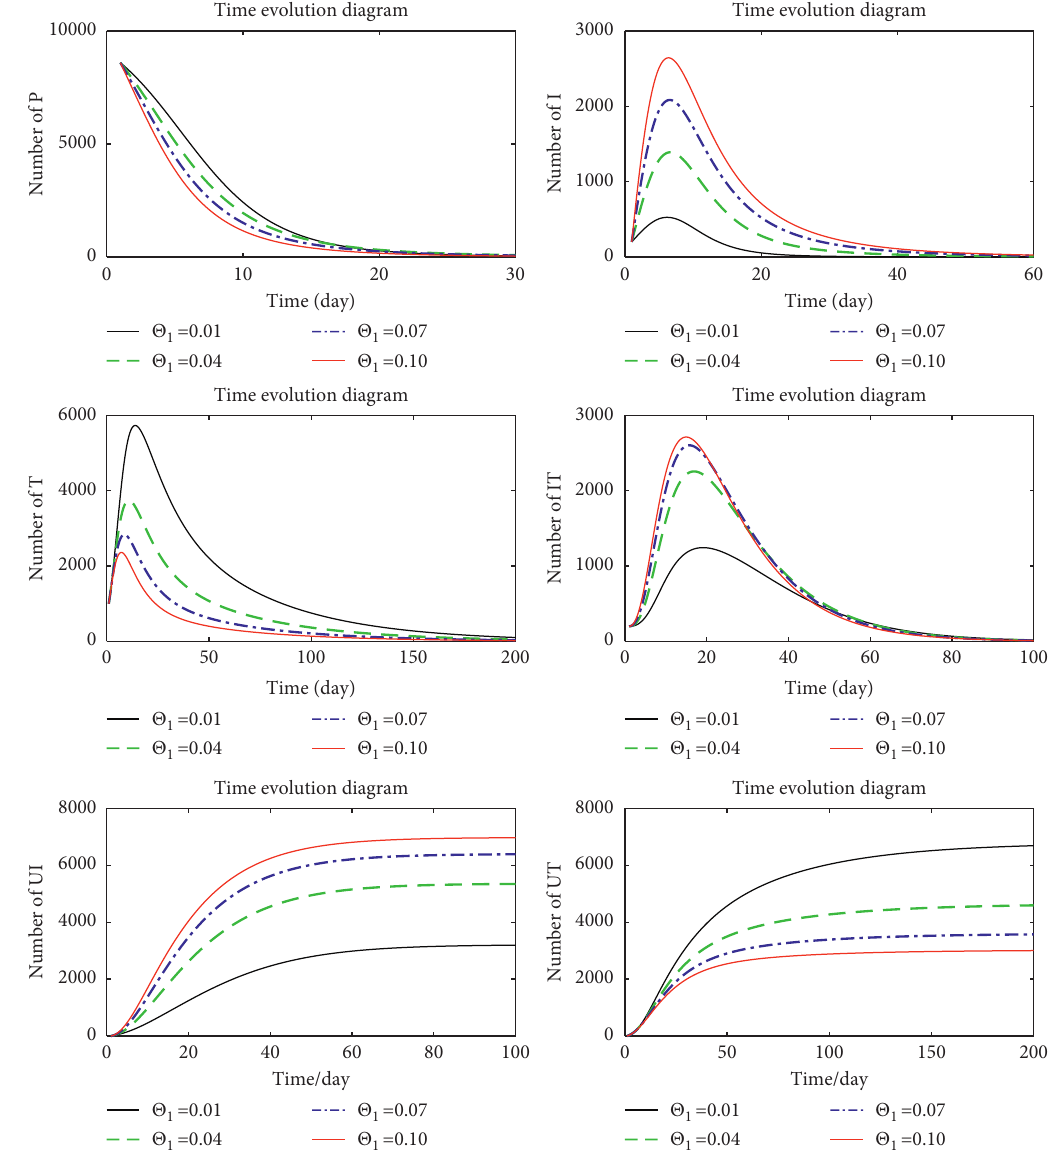
Figure 2: Time evolution graph of the number of nodes changing with a rate of θ